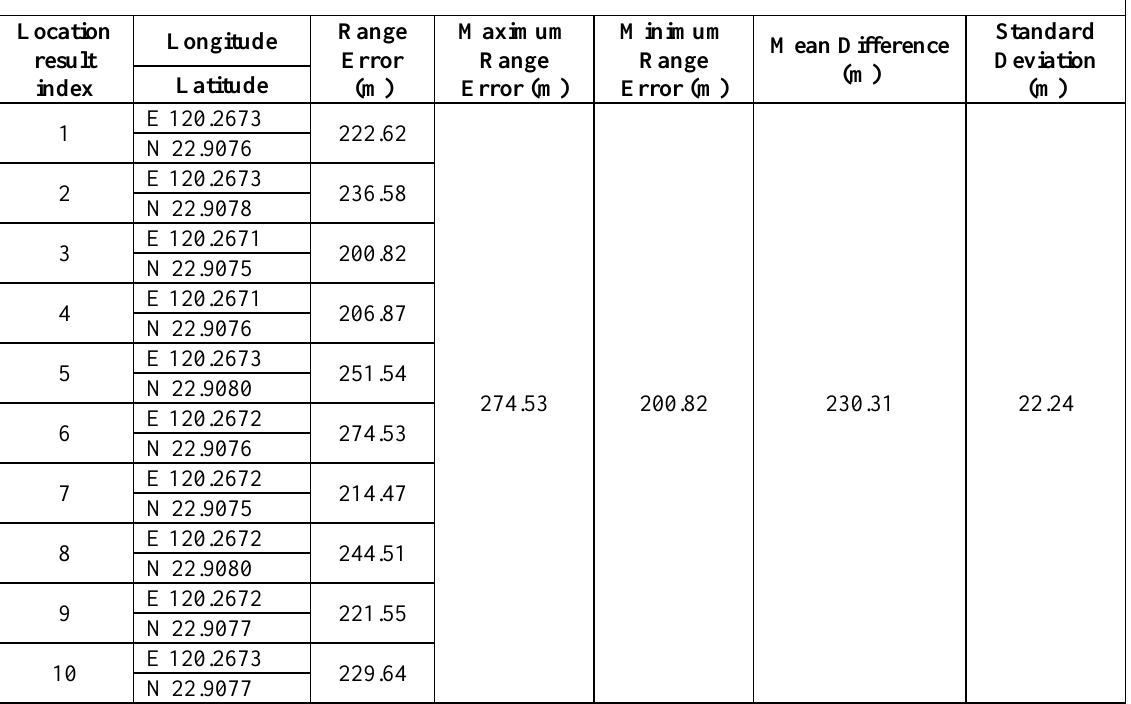
Table 2. The location performance using without genetic algorithm for the measured 88.3 MHz broadcasting